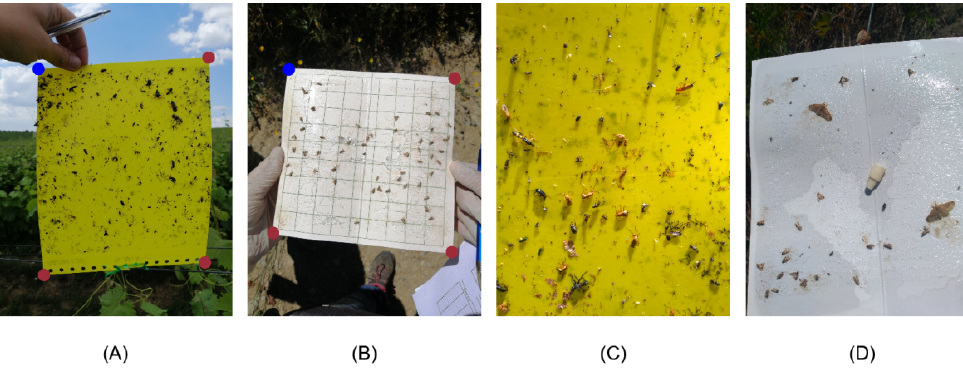
Figure 4. Illustrative images of: CT ( A ) and DT ( B ) images with respective ground truth trap location; ( C ) excluded image (trap border not visible); and ( D ) excluded image (not all trap corners appear within the field of